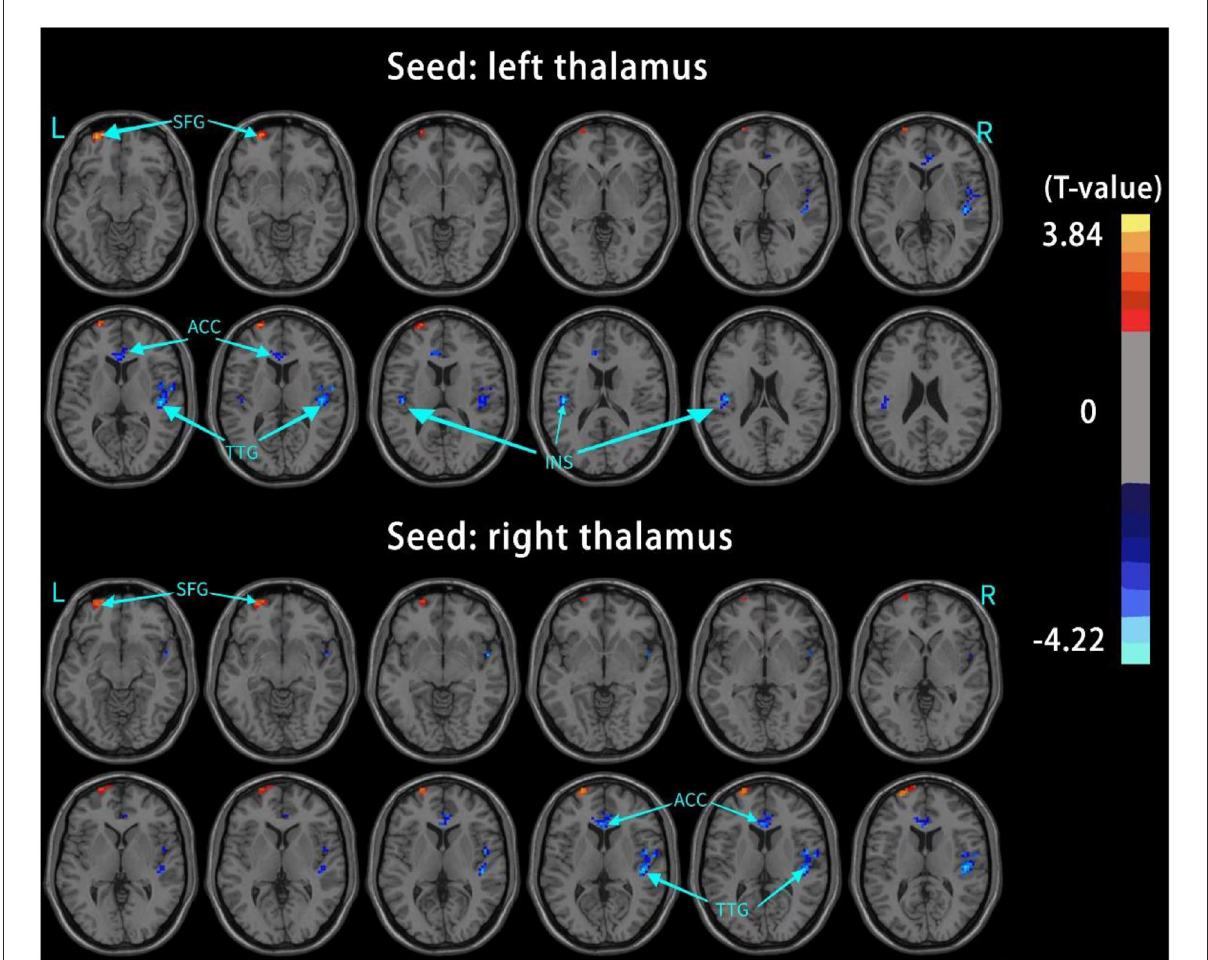
FIGURE1 Brain regions with significant changes in the rs-FC of the bilateral thalamus (voxel-level P < 0.05, AlphaSim corrected), visualized with the DPABI slice viewer (http://rfmri.org/dpabi). Significant group differences in the mean weighted rs-FC in the above regions ( P < 0.05). TTG, transverse temporal gyrus; ACC, anterior cingulate cortex; INS, insula; SFG, superior frontal gyrus.